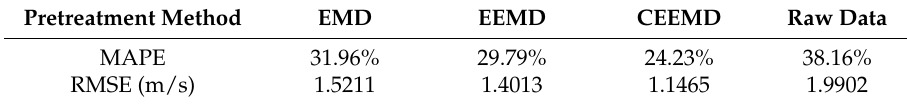
Table 3. Result of multistep forecasting for wind speed with data before and after pretreatment.